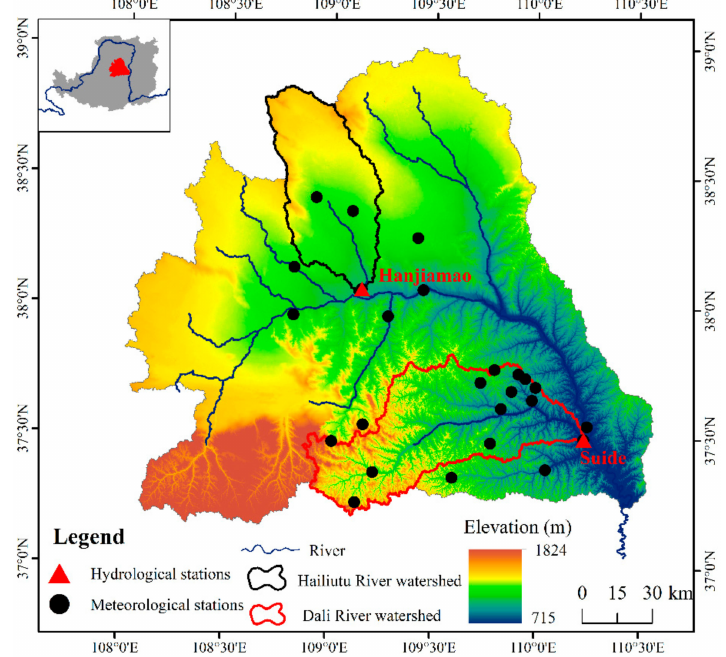
Figure 1. Location of Hailiutu River watershed and Dalihe River